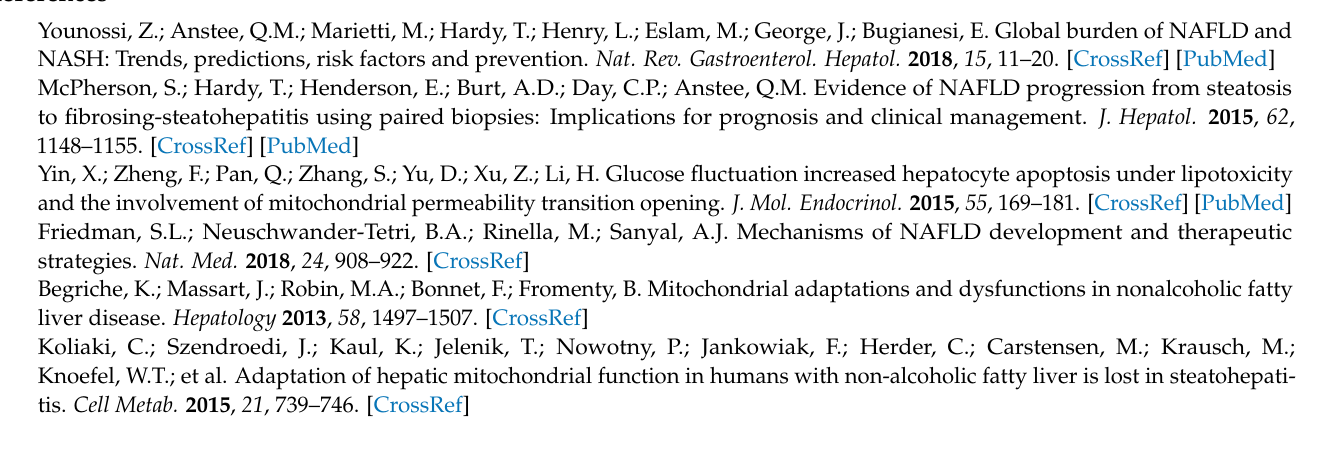
Figure S3: Western diet (WD) induces a distinct neutral lipid accumulation profile; Figure S4: Western diet (WD) induces higher levels of phosphatidylinositol (PI) up to 22 weeks, in comparison with the standard chow diet (SD); Figure S5: Hepatic mitochondria isolated from Western diet (WD)-fed mice has higher susceptibility to mitochondrial permeability transition pore (MPTP)